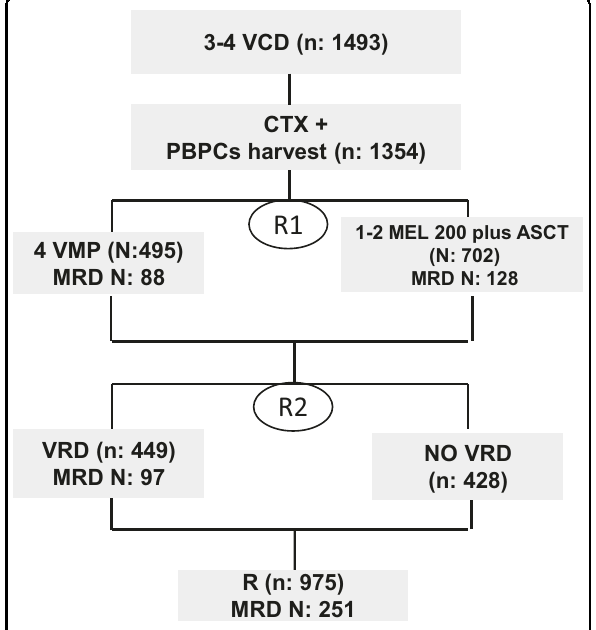
Fig. 1 Study design. VCd, bortezomib-cyclophosphamide- dexamethasone; VMP, bortezomib-melphalan-prednisone; ASCT, autologous stem-cell transplantation; VRD, bortezomib-lenalidomide- dexamethasone; CTX, cyclophosphamide; PBPCs, peripheral blood plasma cells; R1, fi rst randomization; R2, second randomization; R, lenalidomide; MRD, minimal residual